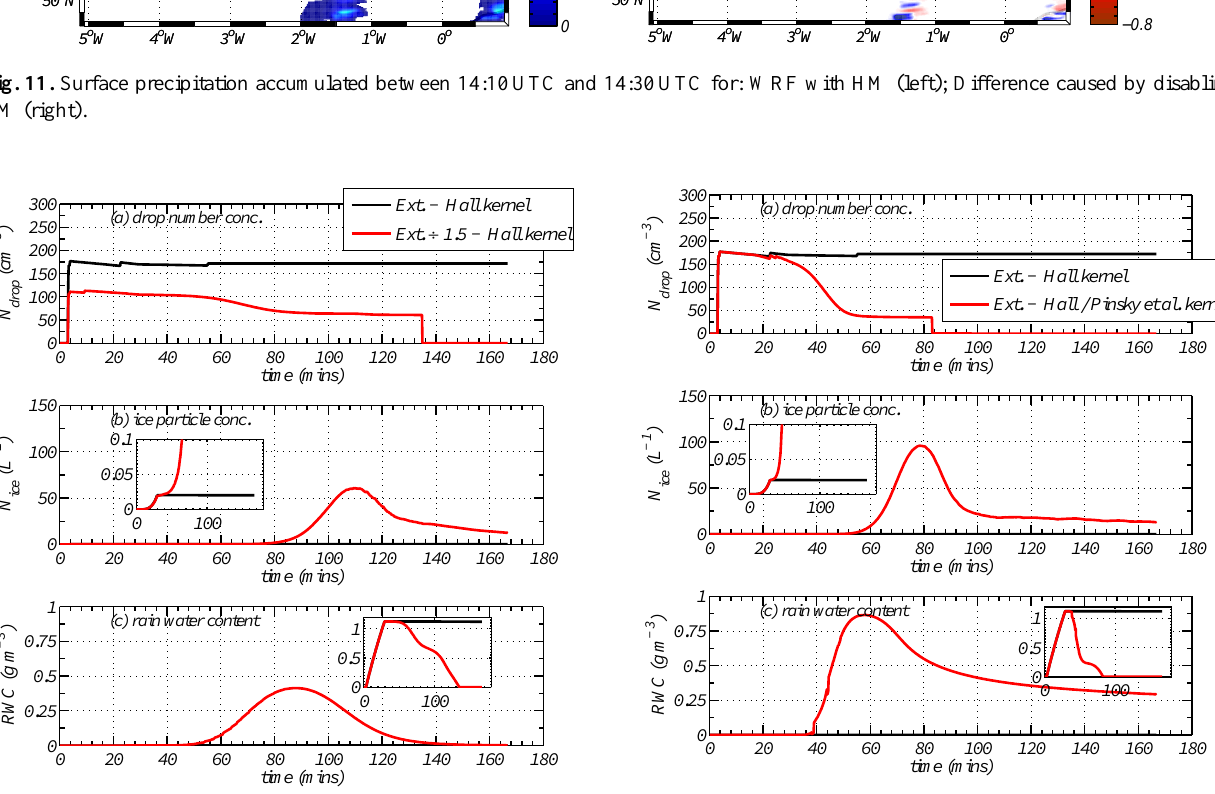
Fig. 12. Time series plots summarising the results from the ACPIM run using the input aerosol distribution assuming external mixture 2 (see text and Fig. 6b) – black lines – and the same distribution but with concentrations reduced by a factor of 1.5 (red lines) – both using collection kernel of Hall (1980). (a) number of activated cloud drops; (b) ice particle number concentration (inset is expanded to show lower scale); (c) rain water content (inset is the cloud water content). Note water is categorised as rain if the size is greater than 80µm diameter.